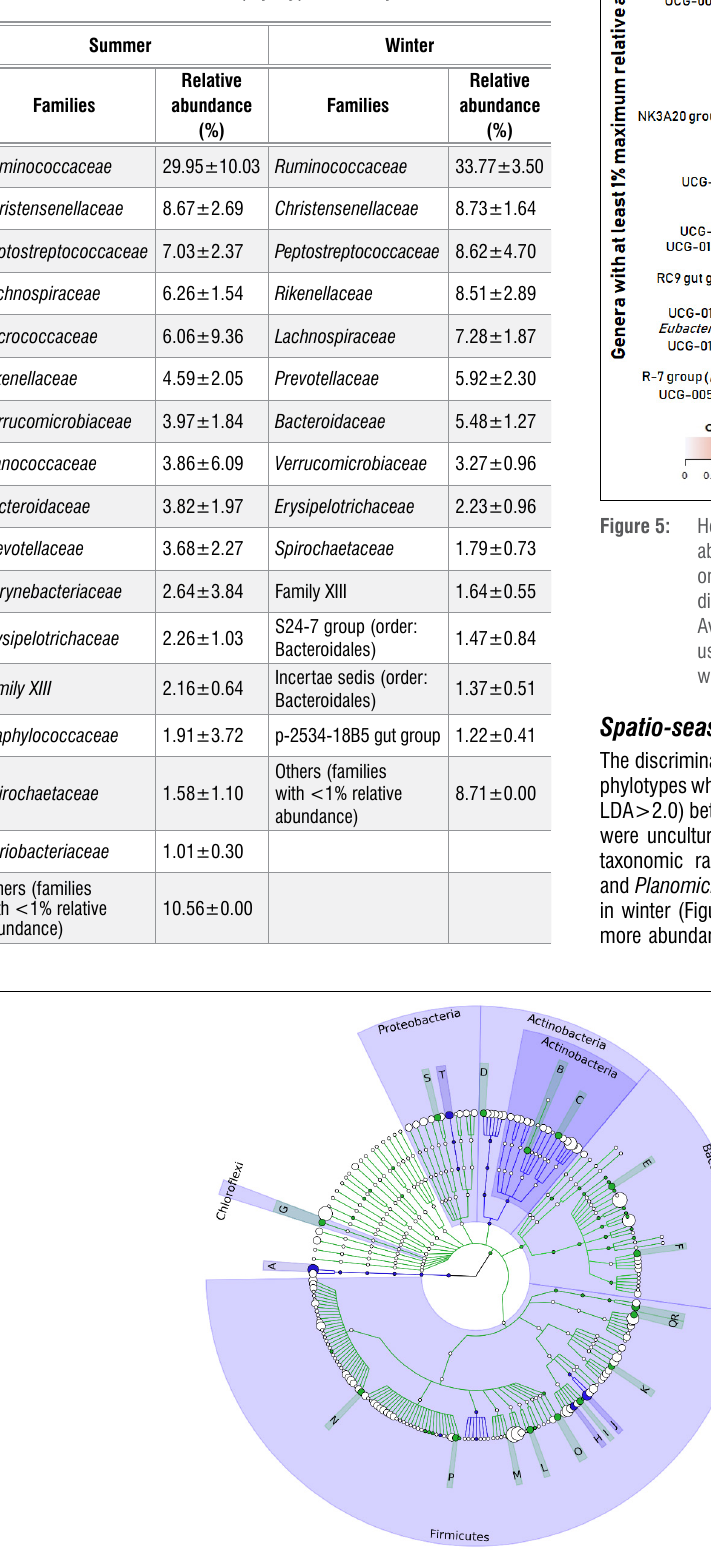
(Figure 5) constitute the ‘core microbiome’ of Zulu sheep faeces. Table 3: Relative abundance of phylotypes at family taxonomic level